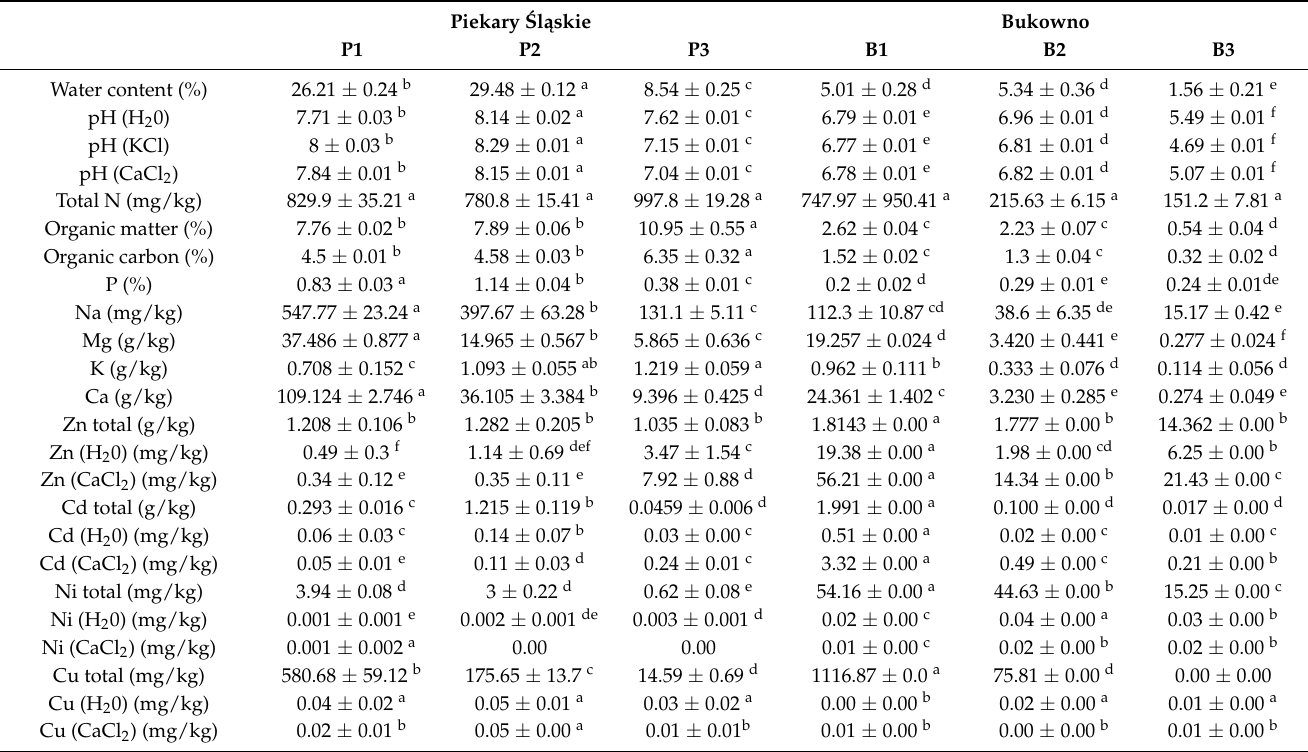
Table 1. Physicochemical characterization of soil samples. Piekary ´Sl